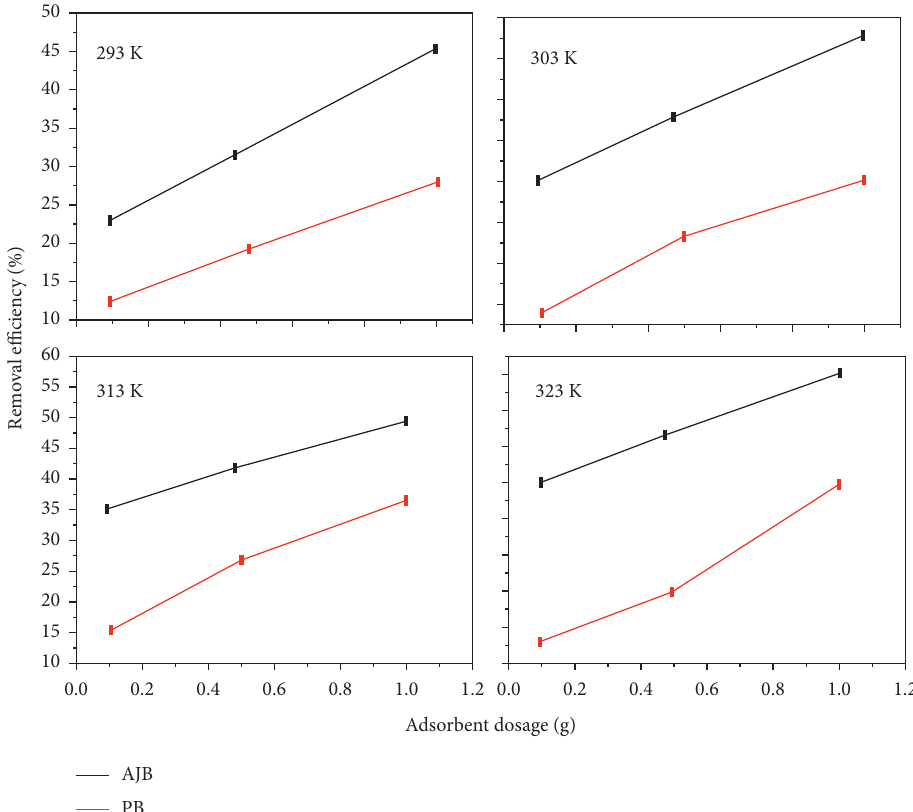
Figure 6: Effect of adsorbent dosage on the percentage removal of TPC at different temperatures.